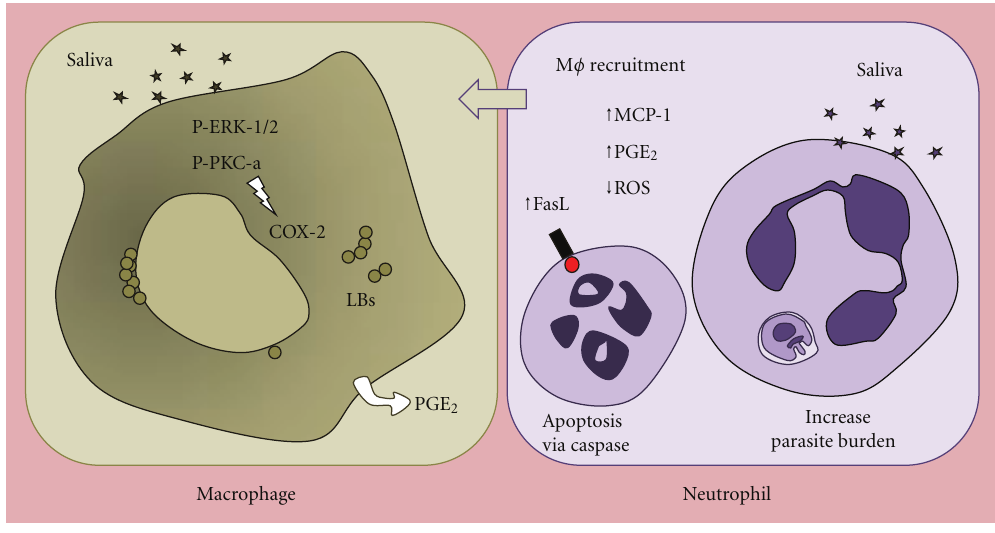
Figure 3: E ff ects of Lutzomyia longipalpis saliva on macrophage activation and neutrophil apoptosis. Macrophages and neutrophils are the first host cells to contact Leishmania after sand fly bite. Saliva triggers macrophages activation by lipid bodies formation committed with the PGE 2 production via COX-2 after phosphorilation of kinases. On the other hand, saliva induces neutrophil apoptosis by caspase and FasL activation. In addition, neutrophils activated by saliva become susceptible to Leishmania chagasi and release MCP-1, which is associated with macrophage recruitment. This scenario promoted by L. longipalpis saliva can contribute to Leishmania transmission in the early times of